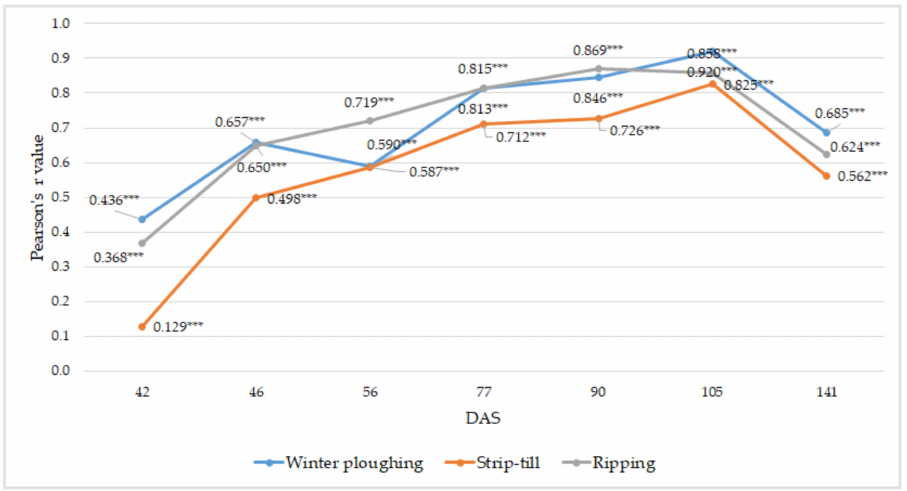
Figure 9. Pearson’s correlation coefficient (r) dynamics among NDVI UAV and yield t ha − 1 as a result of tillage systems (2021, Debrecen). Note: ***. Correlation is significant at the 0.001